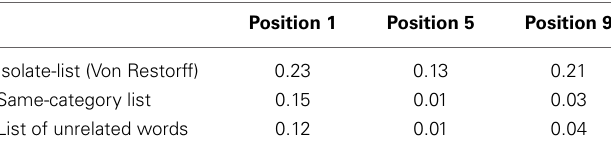
Table 4 | Probability of first recall for the critical word only in different embedding lists (Experiment 2a).